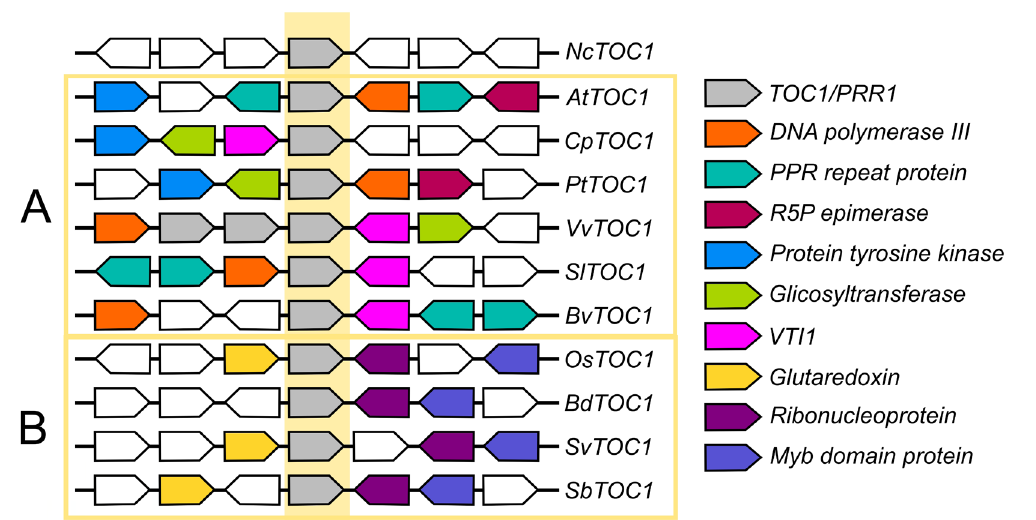
Figure 2 - Positional orthology of members of the TOC1/PRR1 clade. The flanking genes of the TOC1 / PRR1 orthologs (grey polygons in the yellow centre) of eleven vascular plant clades were identified and colour-coded according to their identity—the polygons point toward the annotated direction of the gene. Two groups of orthologs can be identified through similarities: one for eudicots (A) and one for monocots (B) . Sequences ID can be found in Table